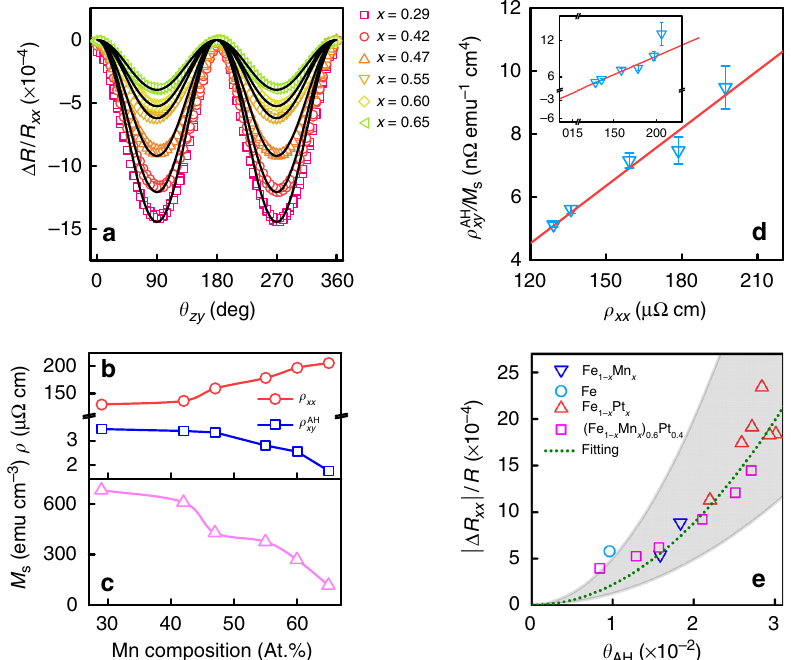
vs. ρ xx plot, and solid s